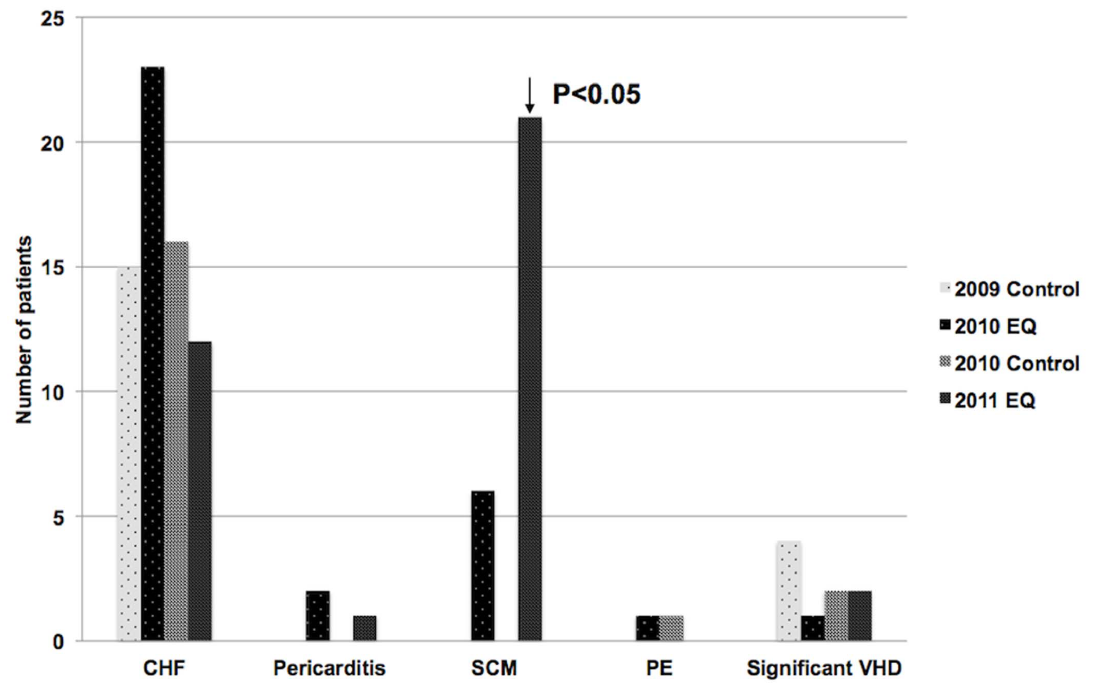
Figure 6. Other cardiac presentations in the first 2 weeks following both earthquakes. CHF = congestive heart failure; PE = pulmonary embolus; VHD = valvular heart